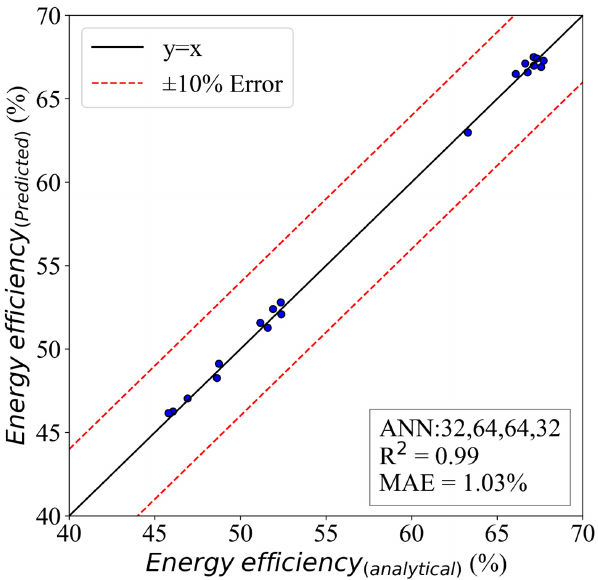
Figure 12. The ANN model of energy efficiency with an HL structure of (32,64,64,32).